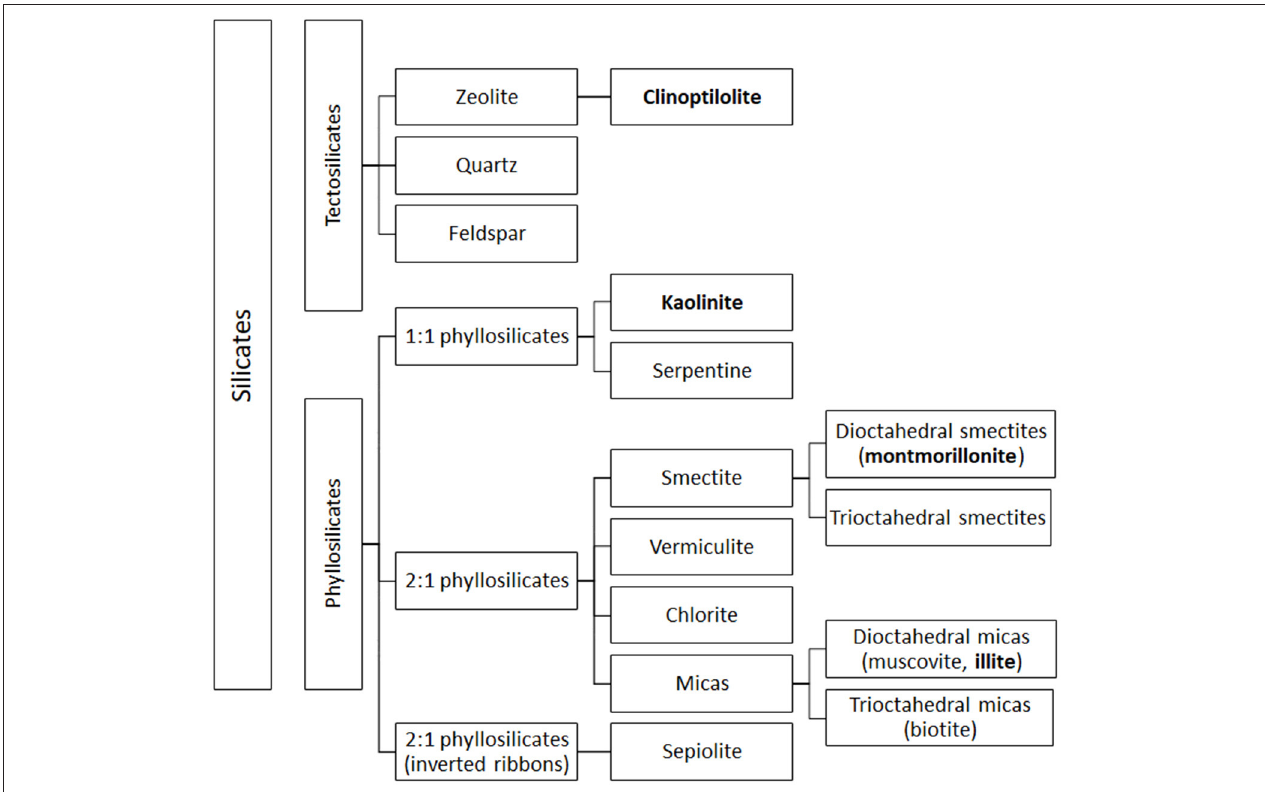
FIGURE 2 | Simplified classification of silicates. Clay subfamilies and species used and present in feed additives are indicated in bold. Most clay minerals used as animal feed additives belong to the phyllosilicate family. The figure includes also the classification of tectosilicates of sedimentary origin, such as CPL, a natural zeolite that may be used as a technological additive in animal